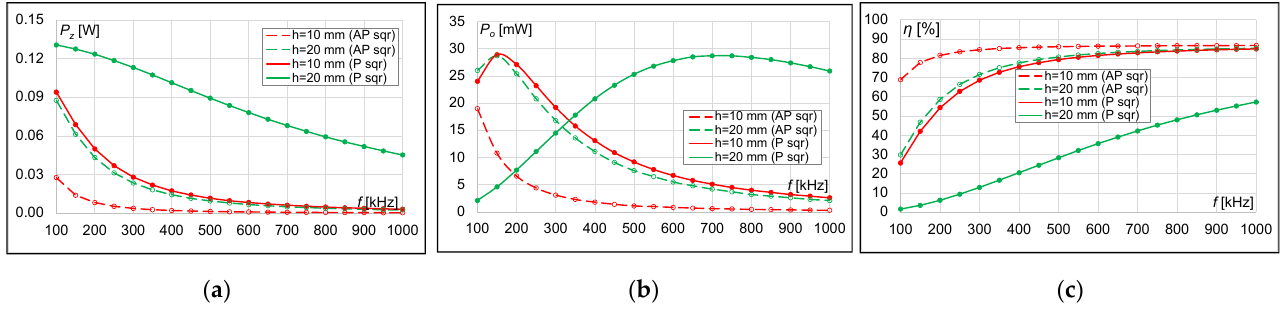
Figure 17. Results for square coils with r = 20 mm and the number of turns n = 60 at two distances ( h = 10 mm and h = 20 mm): ( a ) transmitter power, ( b ) receiver power, ( c ) power transfer efficiency.